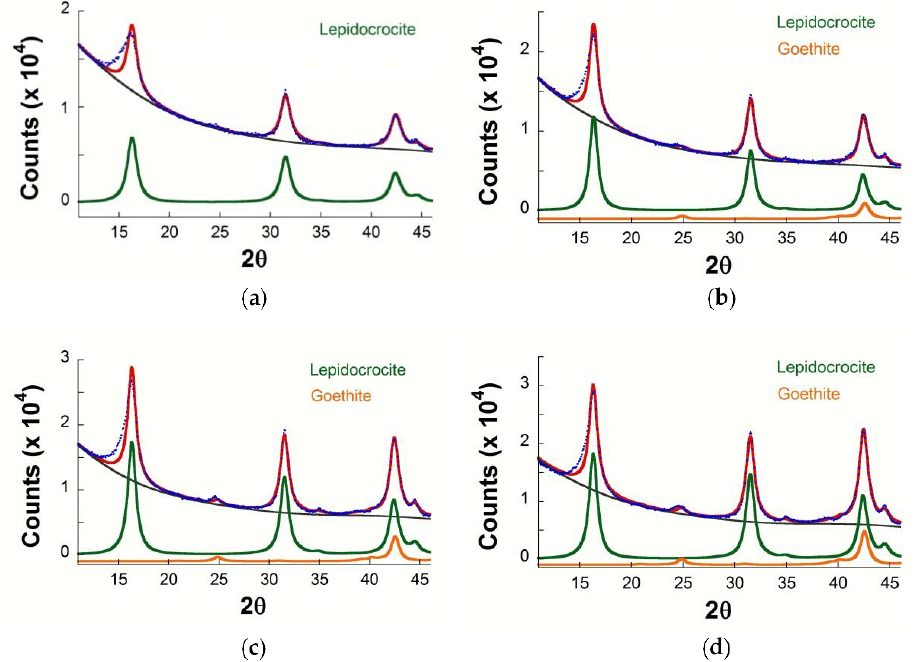
Figure 10. Comparison of the observed (blue circles) and calculated (red line) XRD patterns obtained after Rietveld refinement of the natural patinas exposed during ( a ) 3, ( b ) 6, ( c ) 12 and ( d ) 24 months. The contribution of lepidocrocite and goethite are plotted in different colors.